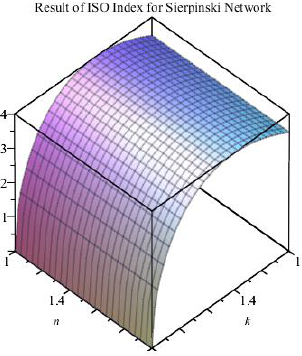
Figure 14. Result of ISO index for Sierpinski network S ( n , k) .